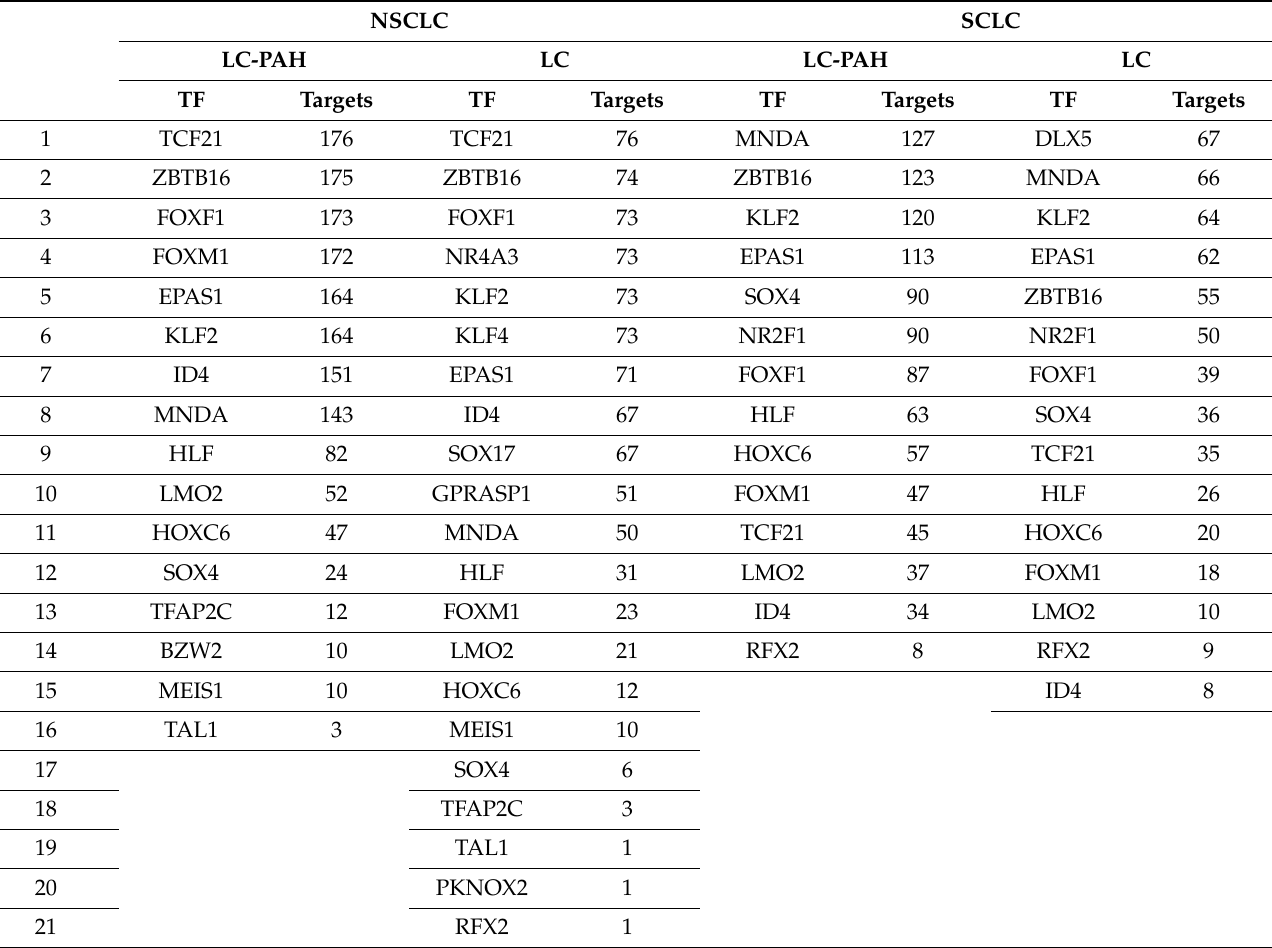
Table 5. Gene regulatory networks (GRNs) of the most frequently dysregulated transcription factors (TFs) of the two types of lung cancer: non-small-cell lung cancer (NSCLC) and small-cell lung cancer (SCLC). The number of most frequently dysregulated DEG targets in lung cancer and pulmonary arterial hypertension (LC-PAH) and only in lung cancer (LC) of each most frequently dysregulated transcription factor (TF). NSCLC SCLC LC-PAH LC LC-PAH